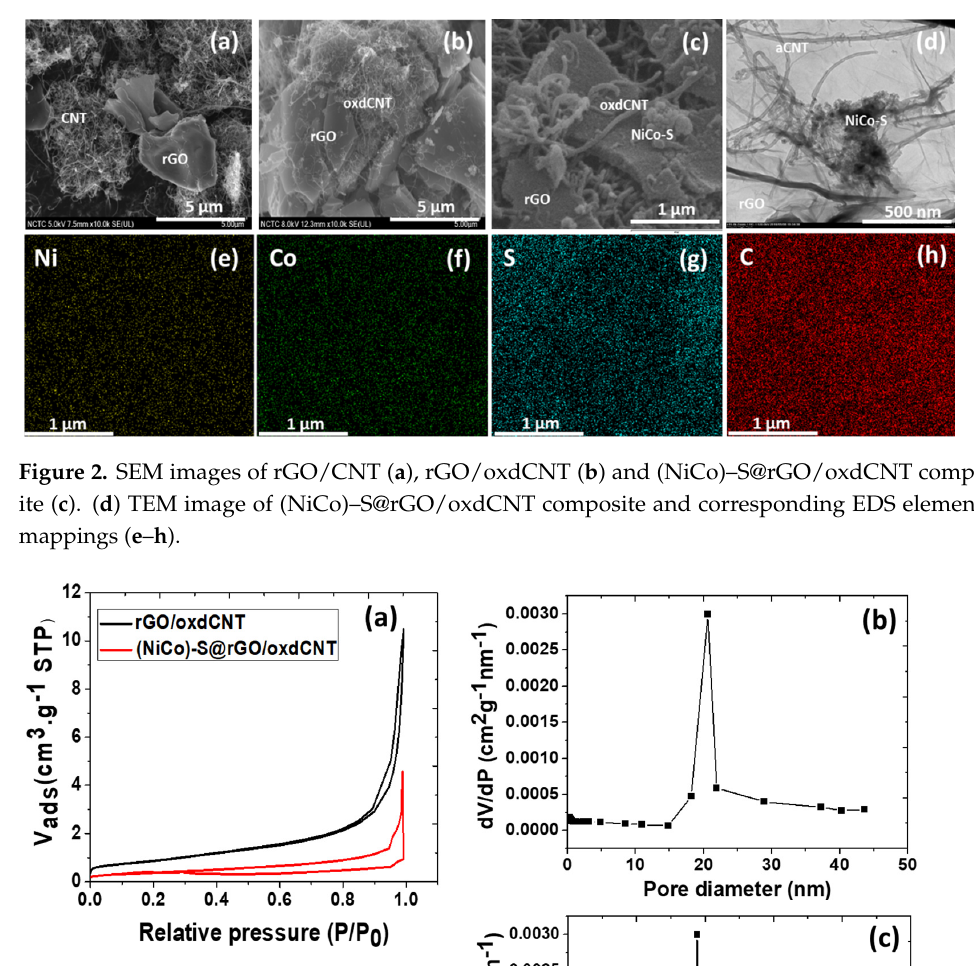
Figure 2. SEM images of rGO/CNT ( a ), rGO/oxdCNT ( b ) and (NiCo)–S@rGO/oxdCNT composite ( c ). ( d ) TEM image of (NiCo)–S@rGO/oxdCNT composite and corresponding EDS elemental map- pings ( e – h ).